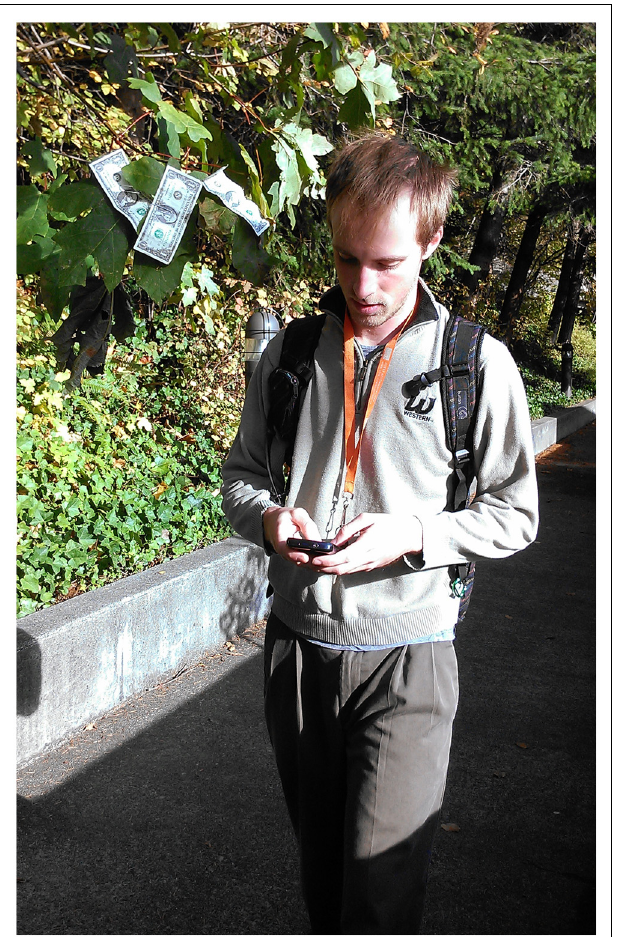
FIGURE 1 |A research assistant walking past the money tree while